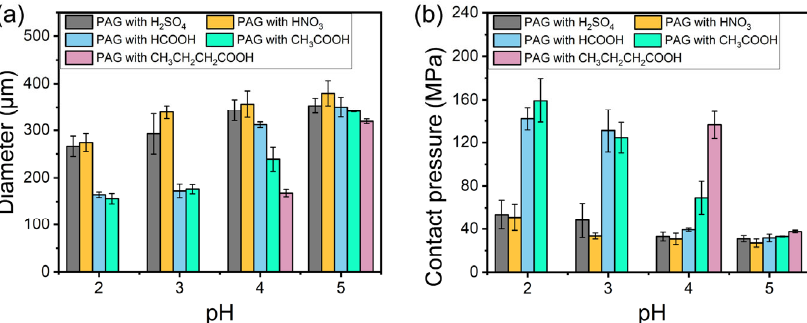
Fig. 4 (a) Diameters of worn regions on the ball and (b) the corresponding contact pressures lubricated by PAG aqueous solutions with different acids at different pH